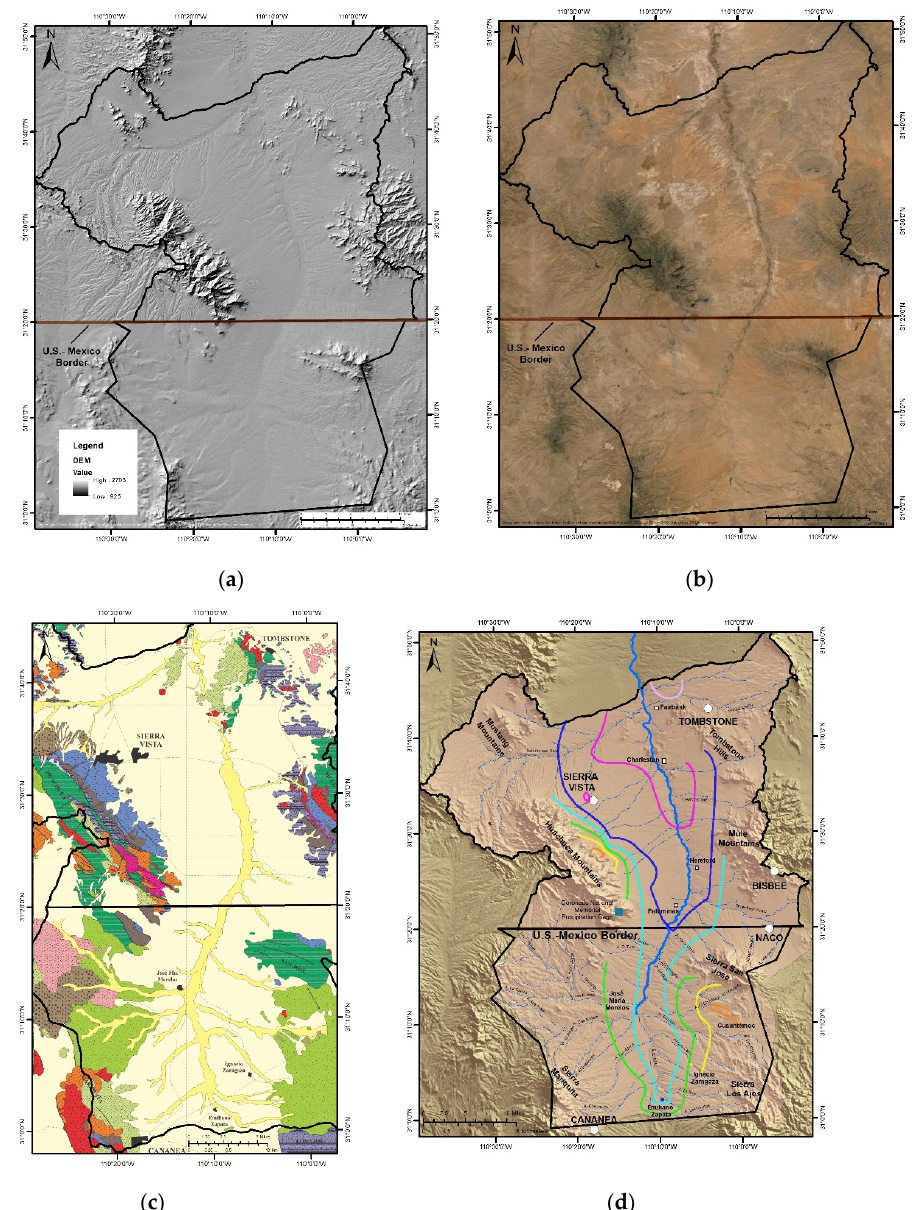
Figure 2. GIS layers used for the development of the hydrogeomorphologic map of the